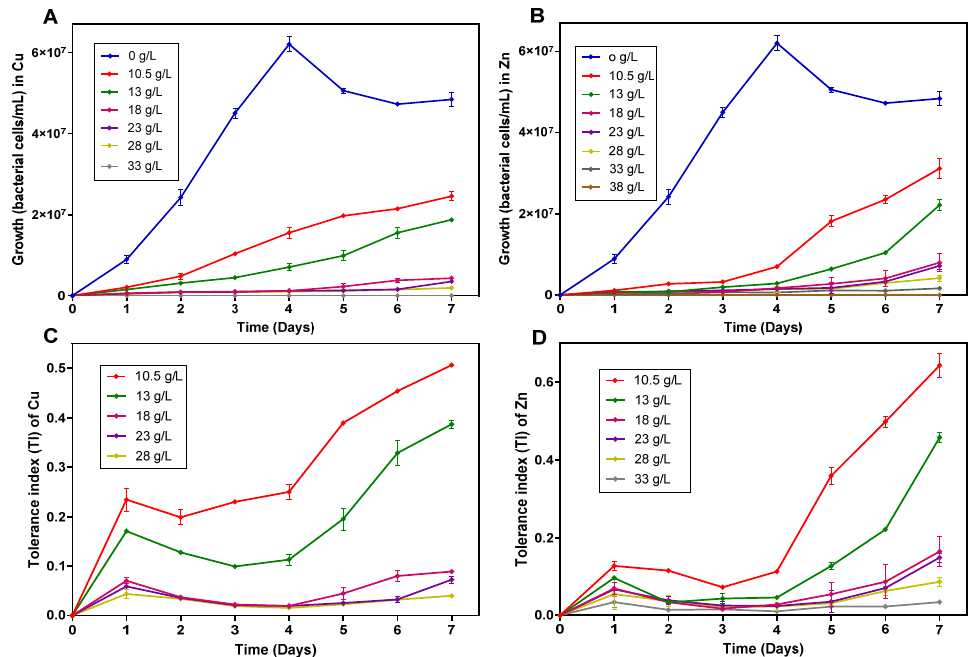
Figure 4. Growth and tolerance indices of the enriched acidophilic iron-oxidizing consortium in the presence of Cu ( A , C ) and Zn ( B , D ).